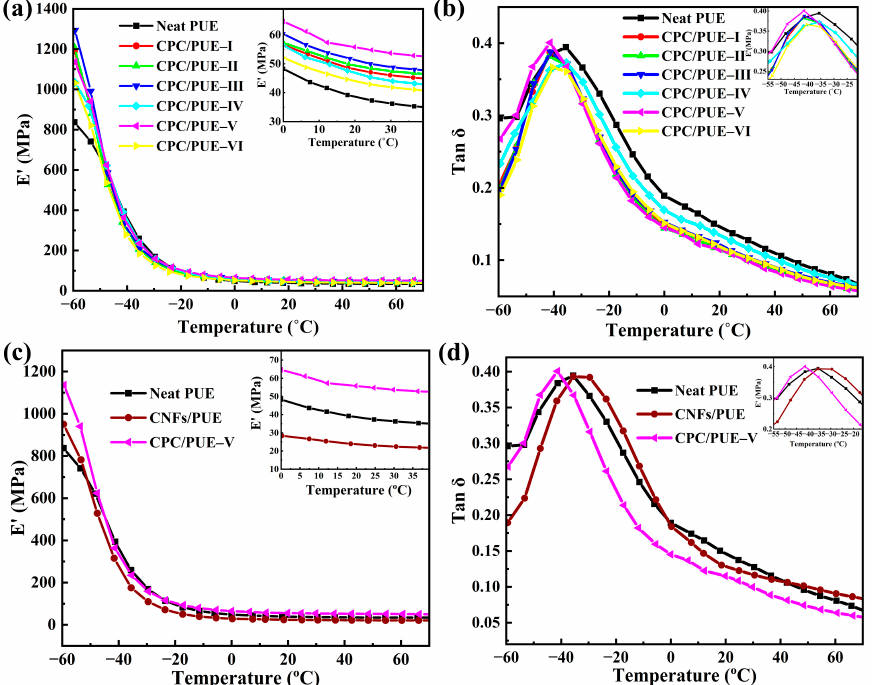
Figure 6. ( a ) E’, ( b ) tan δ and alterations as a function of temperature for neat PUE and CPC/PUE. ( c ) E’, and ( d ) tan δ and alterations as a function of temperature for the neat, CNFs/PUE, and CPC/PUE– Ⅴ .